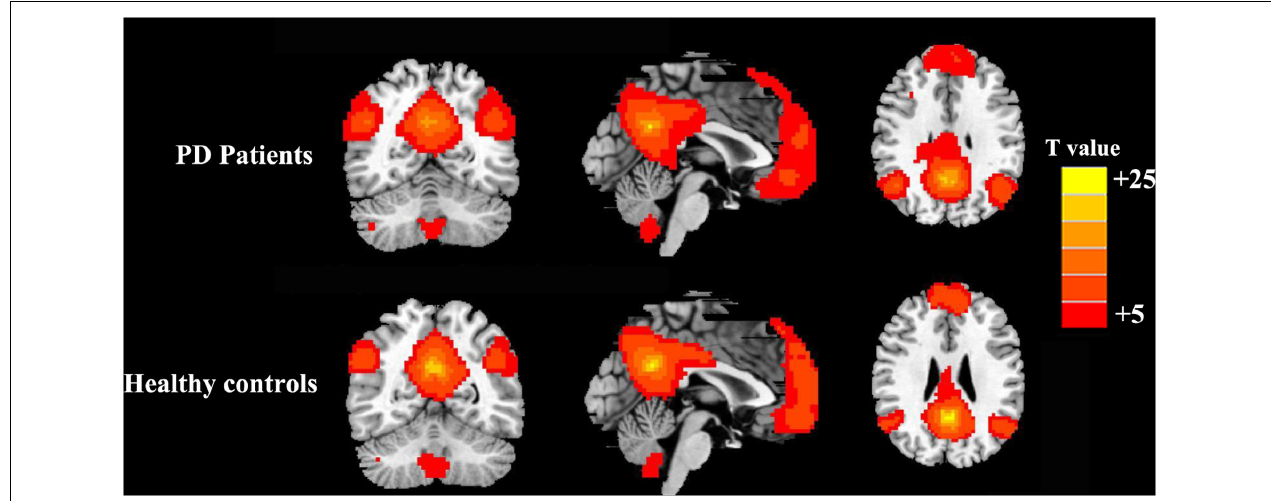
FIGURE 1 | Results of the two components representing the default mode network (DMN) by one-sample t -test in patients with Parkinson’s disease (PD) and healthy controls.